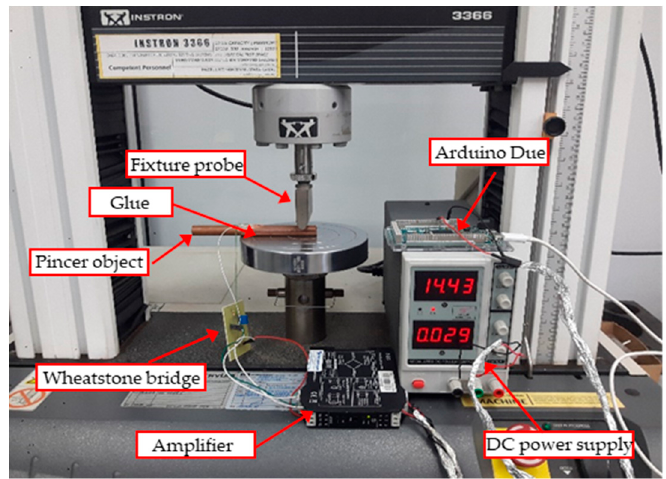
Figure 5. Calibration setup of the pinch force load cell.